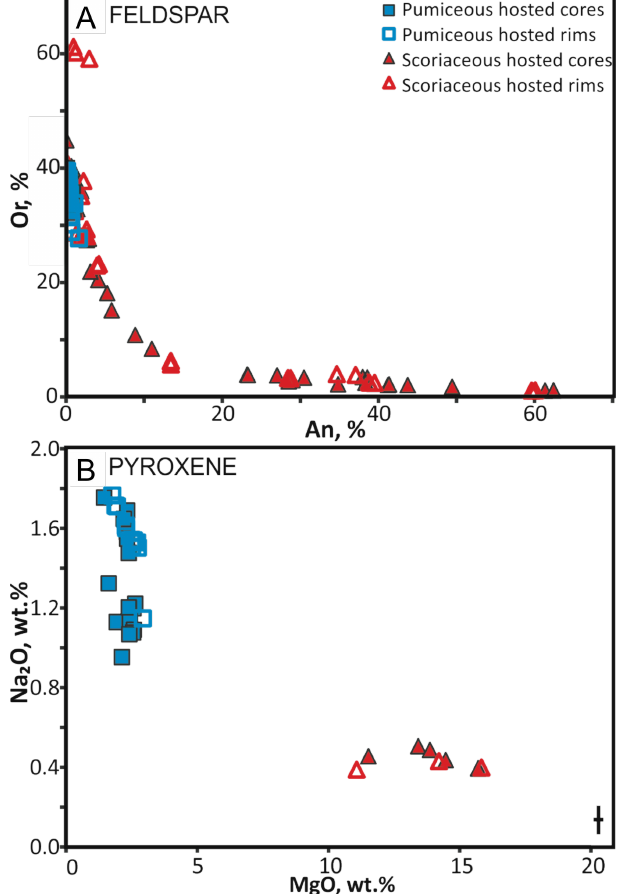
Figure 6: Selected major and trace element data from feldspars [A] and clinopyroxenes [B]. Core analyses are filled symbols, rim analyses are open symbols. Crystals from pumice clasts are in blue, minerals from scoria clasts are in red. Black cross shows the 2 sigma uncer- tainty on analyses [B], uncertainty on feldspar analyses is less than the size of the symbol